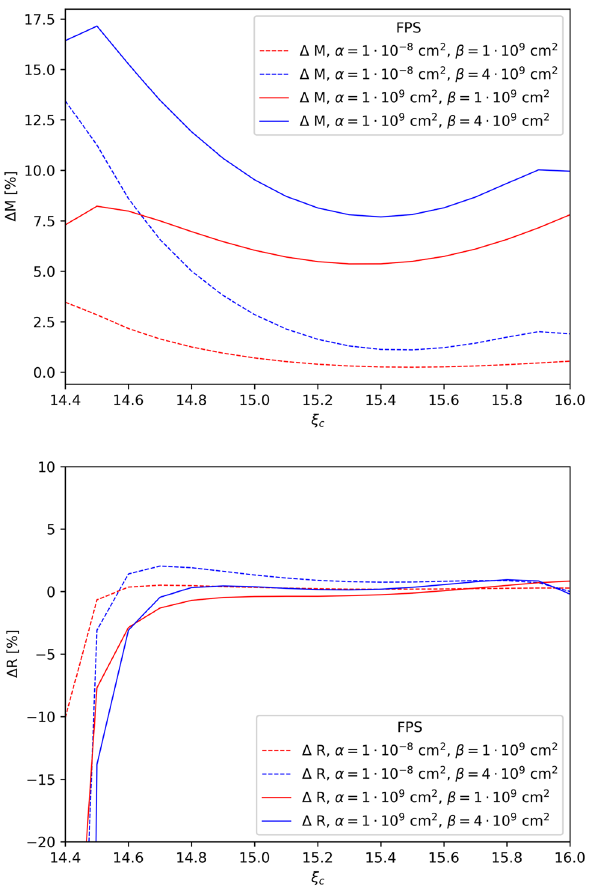
Fig. 16 Difference between the mass (upper panel) and the radius (lower panel) obtained, given a central density value ξ , with f ( R , Q ) = R + α R 2 + β Q and GR, for the HS(DD2)